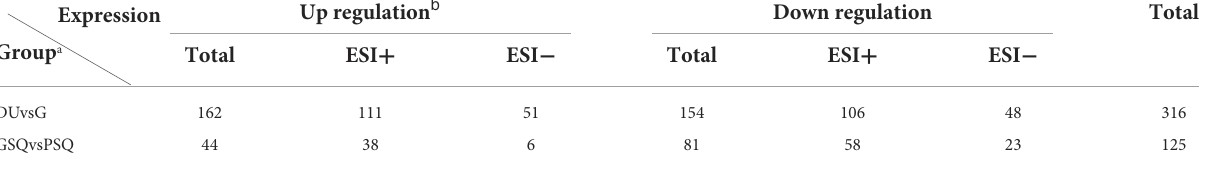
TABLE 2 The results of differential metabolites in different